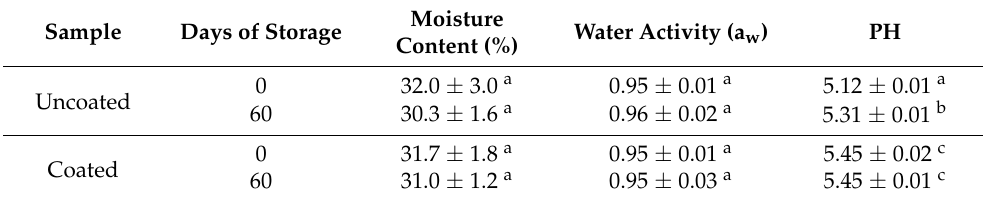
Table 3. Moisture content, water activity, and pH of uncoated and coated Paipa cheese samples.